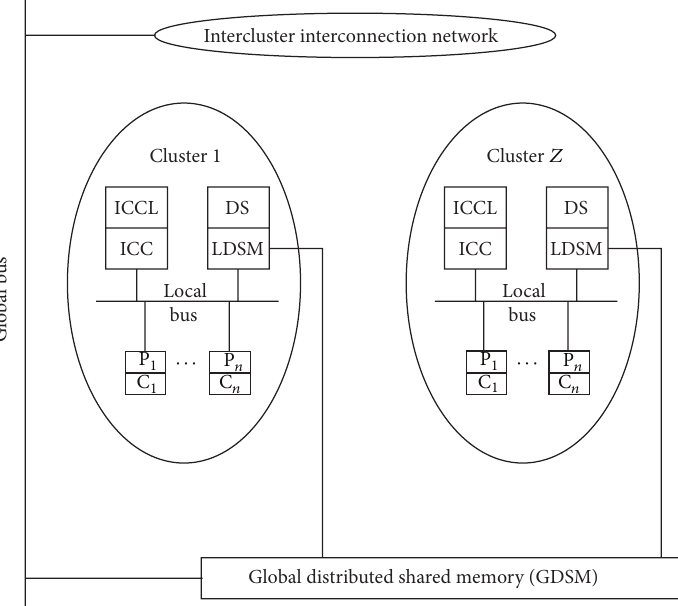
Figure 3: Distributed shared memory cluster architecture